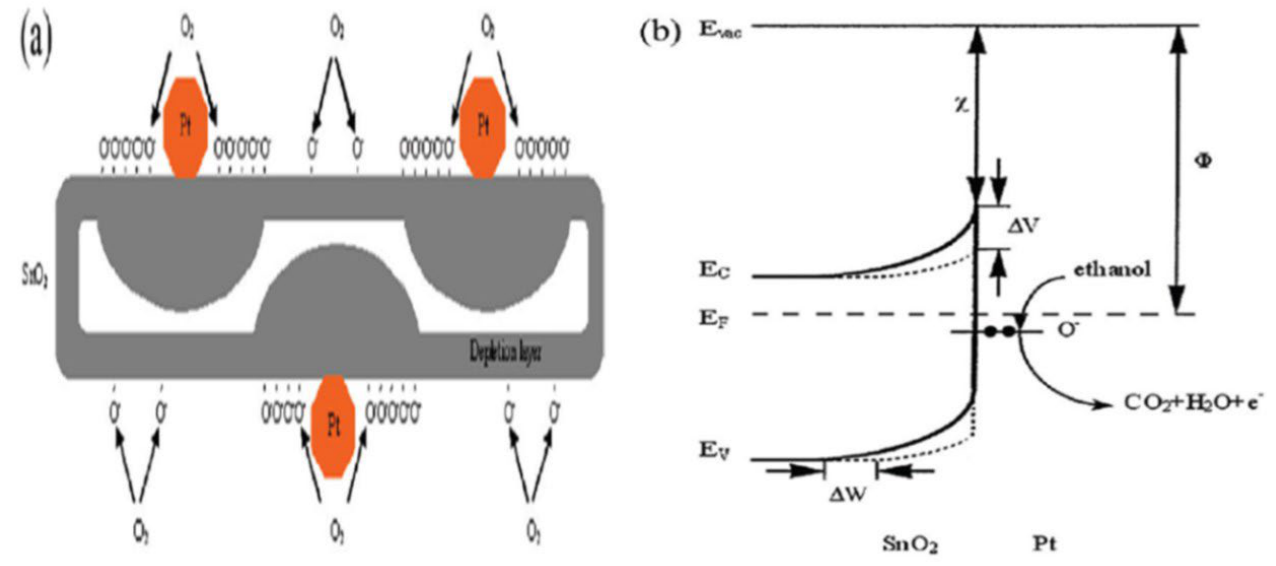
Figure 25. ( a ) Processes taking place at the Pt@SnO 2 surface, oxygen adsorption on the pristine surface of SnO 2 nanorods and dissociation and adsorption of oxygen at the regions close to the SnO 2 /Pt interface. ( b ) The energy band diagram of Pt@SnO 2 nanorods. The solid line depicts the regions close to the SnO 2 /Pt interface, which are wider ( ∆ W) and higher ( ∆ V) than those of the pristine SnO 2 surface represented by a dashed line. In ethanol atmosphere, the electrons are released easily from the surface reaction at the SnO 2 /Pt interface. (Reprinted with permission from [73]. Copyright 2010, American Chemical Society, Washington, DC, USA).